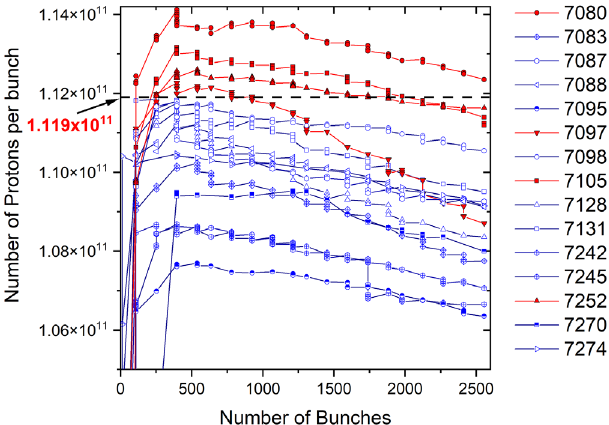
FIG. 6. Evolution of the number of protons per bunch in station 4 (beam 1) as a function of the number of bunches during injection at 450 GeV for several fills (recorded between August 23 and October 9, 2018). Red lines and symbols correspond to fills for which a pressure increase during injection is observed, and blue lines and symbols are related to fills for which no pressure increase